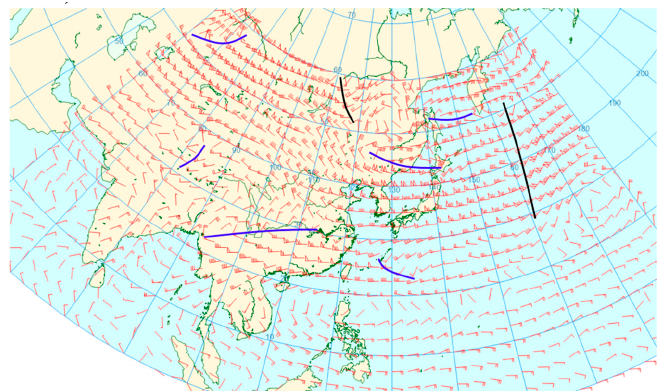
Figure 6. Objective results from the trough line analysis using data from 1600 UTC on 30 April 2009. The black and blue solid lines represent the longwave and shortwave trough lines, respectively.